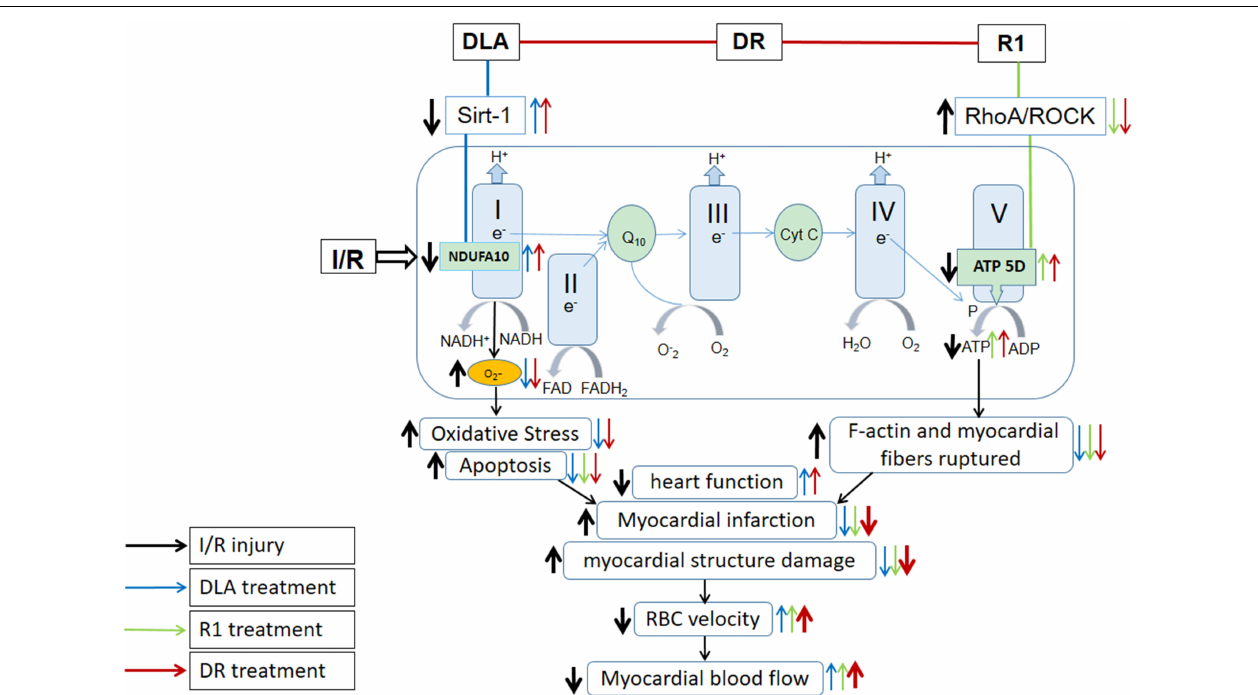
FIGURE 11 | Summary of the effect of DR on myocardial I/R injury and the signaling pathways implicated. DR with DLA and R1 as two ingredients exerted effect by modulating mitochondrial respiratory chain Complex I and V, respectively, thus revealing a better outcome than DLA or R1 alone in TTC, BBC velocity, and MBF, which are the manifestations of a spectrum of